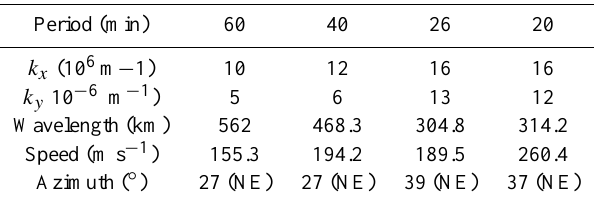
Table 1. Parameter comparison for periods of 60, 40, 26 and 20min derived by